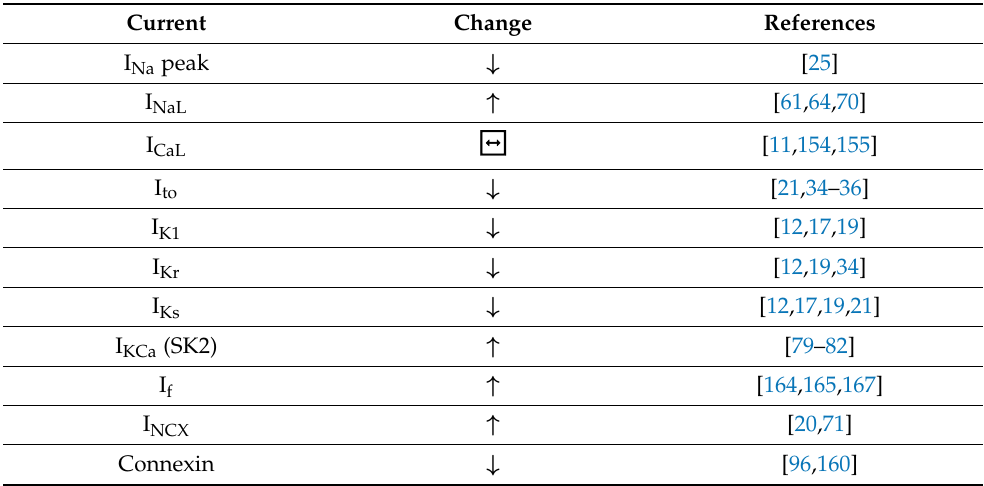
Figure 9. The I f current is upregulated in human terminal heart failure due to ischemic (ICM) and dilated cardiomyopathy (DCM). ( A ) Representative original I f current recordings from a control (donor heart), an explanted ICM and DCM heart, during membrane hyperpolarization to increasing negative potentials from − 60 to − 130 mV. ( B ) Summary graph of I f den- sity at − 120 mV in control, ICM and DCM hearts; ** p < 0.001 vs. control, # p < 0.01 vs. ICM. ( C ) The average I f densities measured in individual control, ICM and DCM hearts [165] ; * p < 0.01 vs. control, # p < 0.05 vs. ICM. Open squares repre- sent the corresponding mean for each